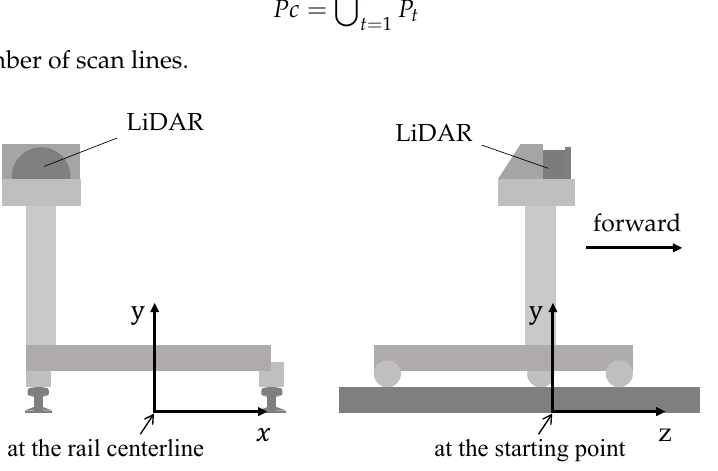
Figure 3. An MLS system carried by an inspection device at the starting point. The front view is shown on the left, and the left view is shown on the right. Since the device moves on the rail, the defined 3D Cartesian coordinate system is relative to rail